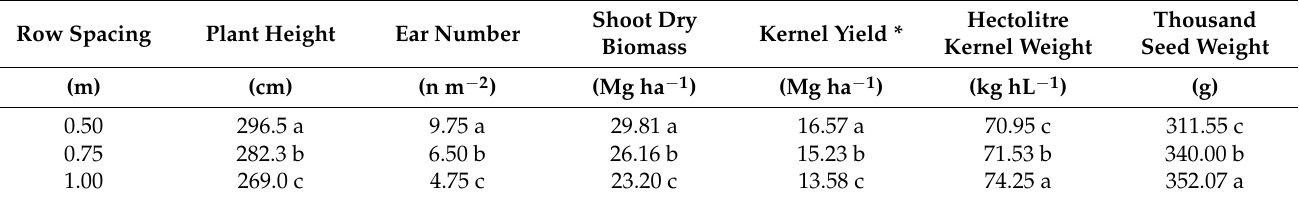
Table 1. Effect of row spacing on morphological, commercial and physiological parameters of maize.